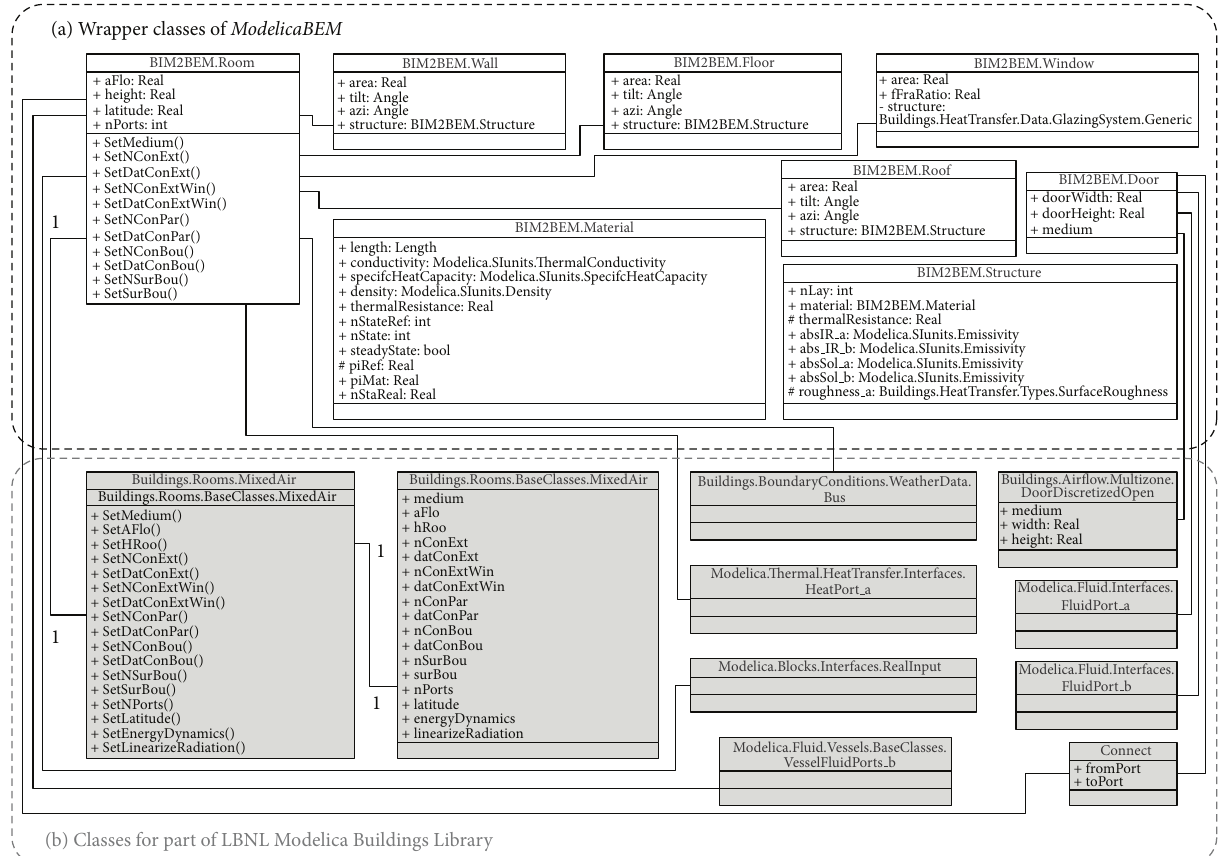
Figure 6: Class diagram of the wrapper